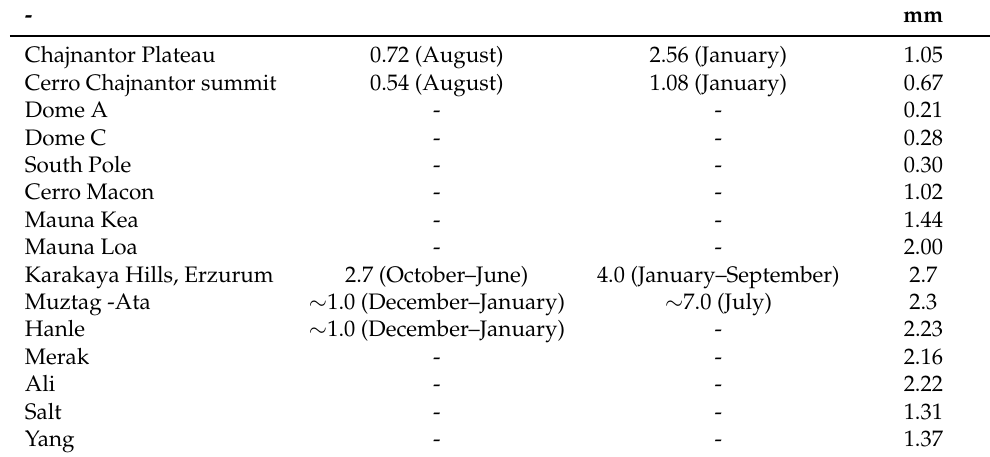
Table 1. Median values of precipitable water vapor at the sites with good astroclimatic conditions [2–6].